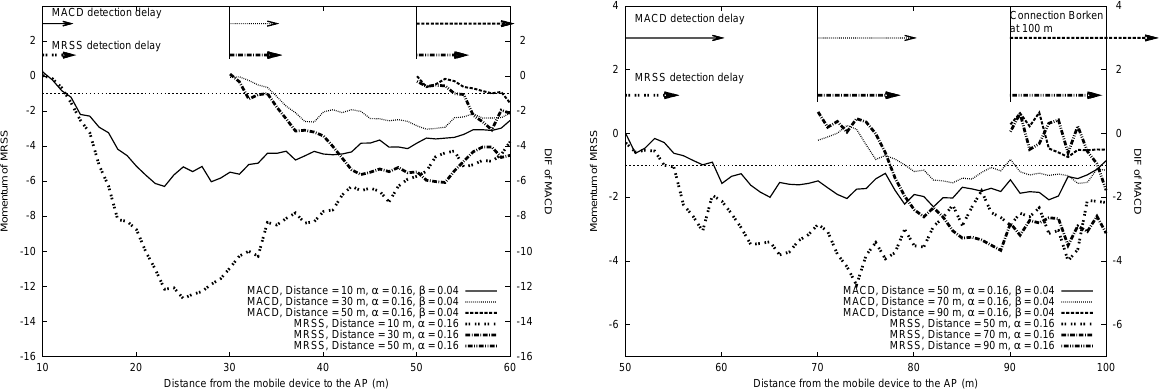
Figure 10. The effect of leaving movement in the WLAN